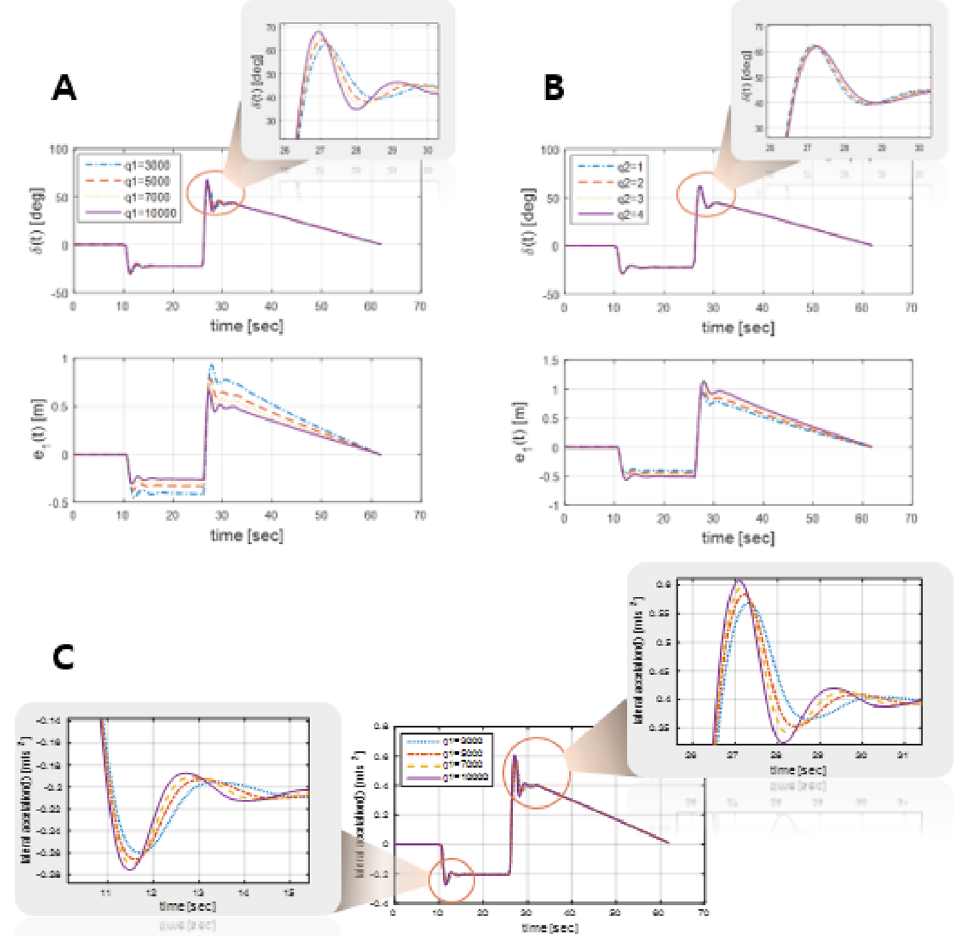
Fig 5. Determination of weighting factors for the state. (A) and (B) The effects of q 1 and q 2 , respectively, which are weighting factors of the state, as given in Eq (13), where e 1 ( t ) indicates the lateral position error of the vehicle with respect to the desired path. It is demonstrated that for achieving path following control with error variables, the weighting factor of the position error must be large, whereas the weighting factor of the position error derivative must be small. (C) The lateral acceleration of the sprung mass with different values of q 1 . As ride comfort is typically evaluated according to the sprung mass of the vehicle, this figure shows a very large q 1 deteriorates ride comfort.